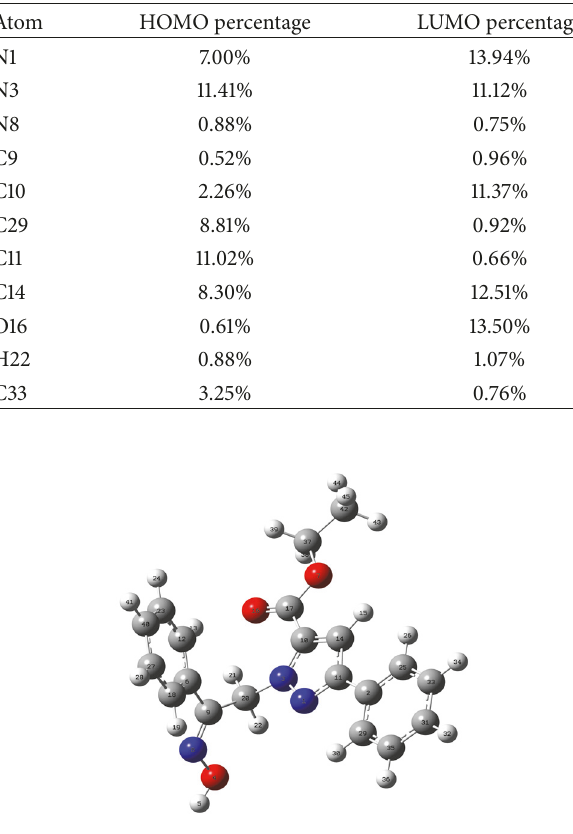
Table 5: The composition (%) of atomic orbitals in HOMO or LUMO of molecule.